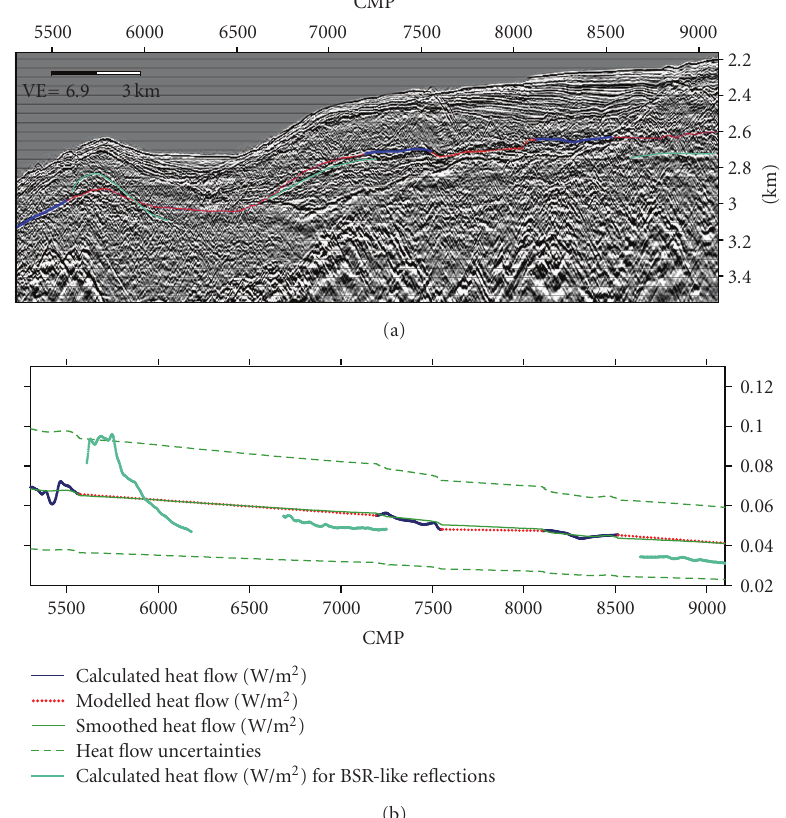
Figure 9: (a) The clear BSR (blue thick line) and predicted BSR (red line) are plotted into the depth-migrated section of line BGR99-46. (b) The turquoise lines are former BSR interpretations for which heat flow values were calculated. The left-most turquoise reflection can be disqualified as a BSR because it exceeds heat flow boundaries and contradicts its trend. The heat flow in the middle belongs to the actual BSR identified in the far o ff set CMP stacks. The reflection marked turquoise on the right belongs to a sediment unconformity.